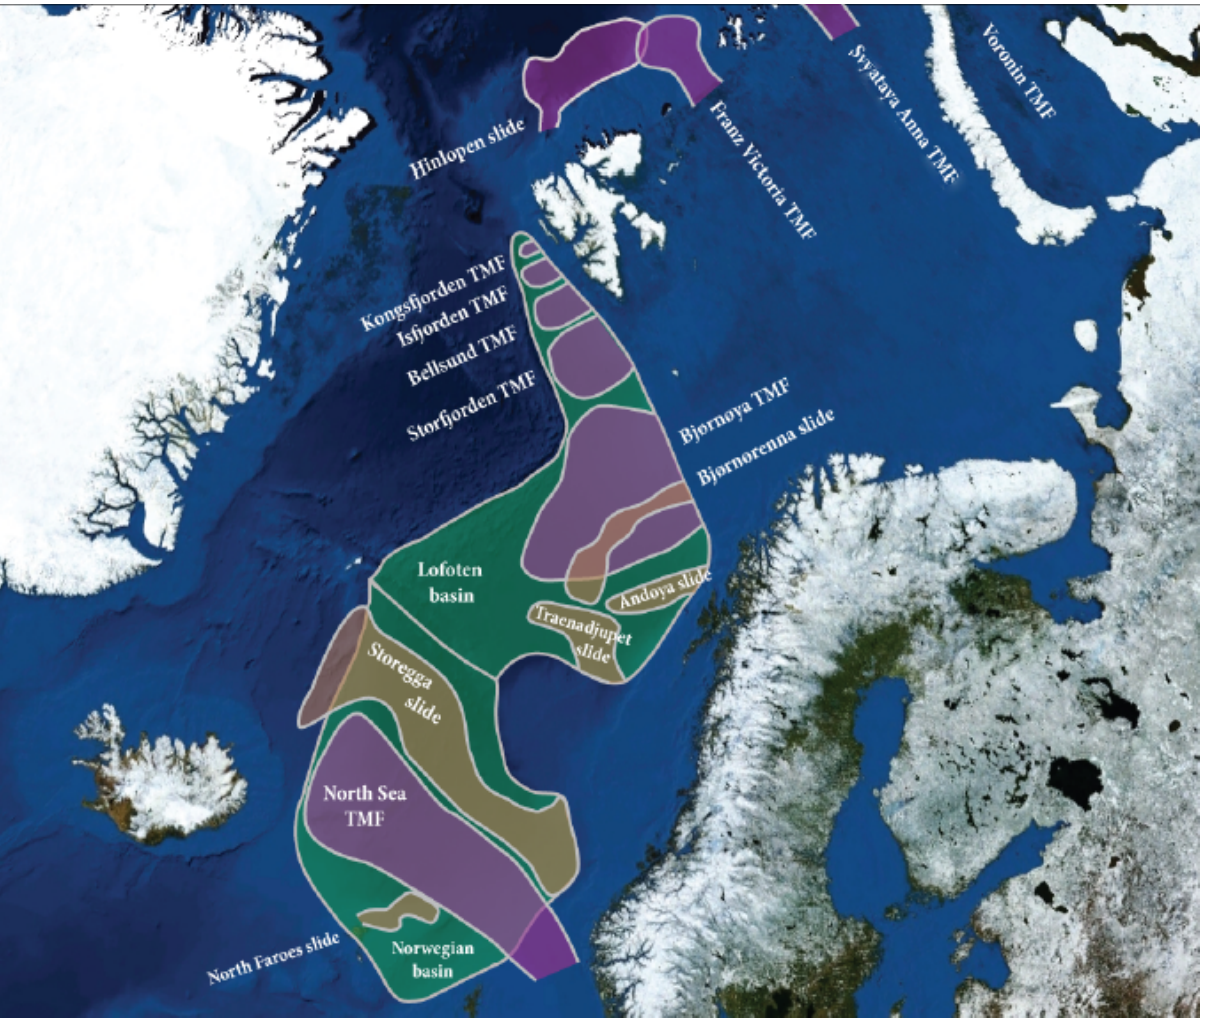
Figure 2. Schematic representation of the locations of trough mouth fans (purple), large-scale failures (brown), and basins (green). Table 1. Maximum effect of sediment loading for different GISR estimates. In each cell the three numbers separated by “|” correspond to earth models M4-16-80|M8-128-150|VM5a, respectively. The maximum effect on relative sea level measurements is calculated as the maximum effect at any of the six sites of Fig. 3 at the time at which there are measurements (shown with vertical bars in Fig. 4). The uplift rate is interpolated at the GPS sites of the BIFROST network presented in Lidberg et al. (2010), and the maximum is shown. The maximum positive rate of change in gravitational acceleration in Scandinavia is determined in the land area contained in the box with longitudes from 5 to 37 ◦ and latitudes from 55 to 71 ◦ N; see Fig. 6. The maximum positive gravity rate in the Barents Sea is determined in the box with longitudes between 10 and 100 ◦ and latitudes between 71 and 81 ◦